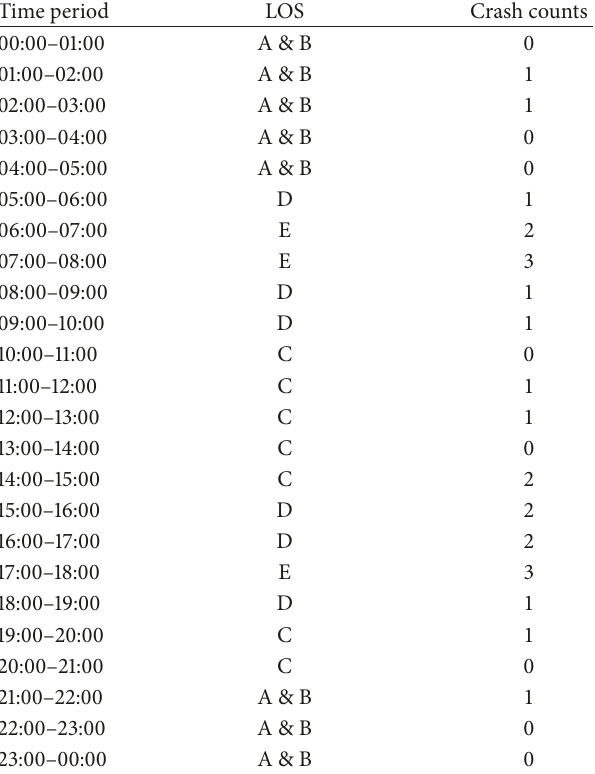
Table1:24-hourbasedcrashcountsonthestudyon-rampfromyear 2005 to year